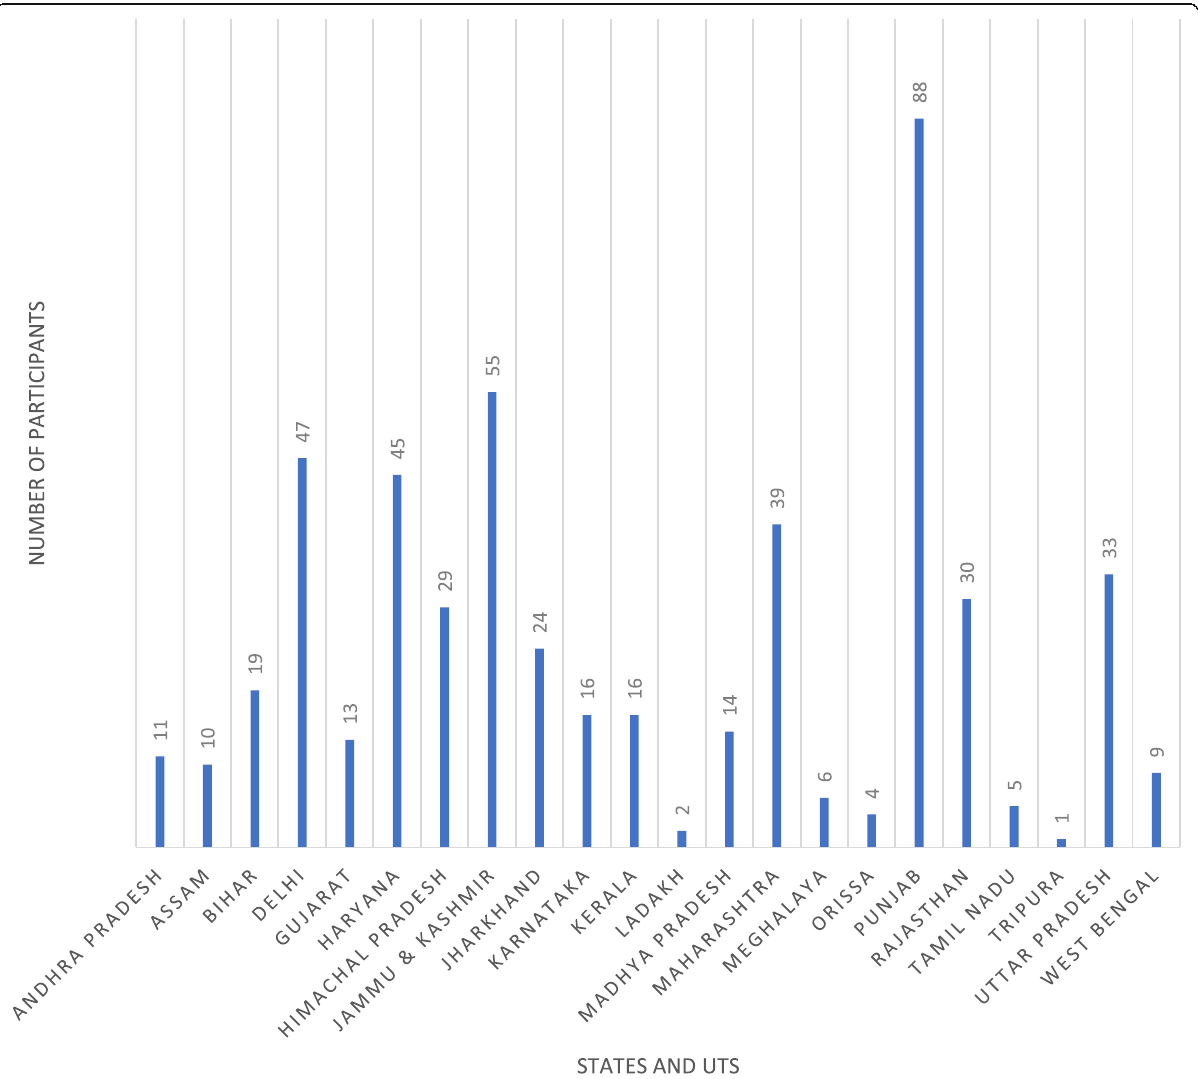
Fig. 1 Graphical representation of the distribution of participants according to the geographical